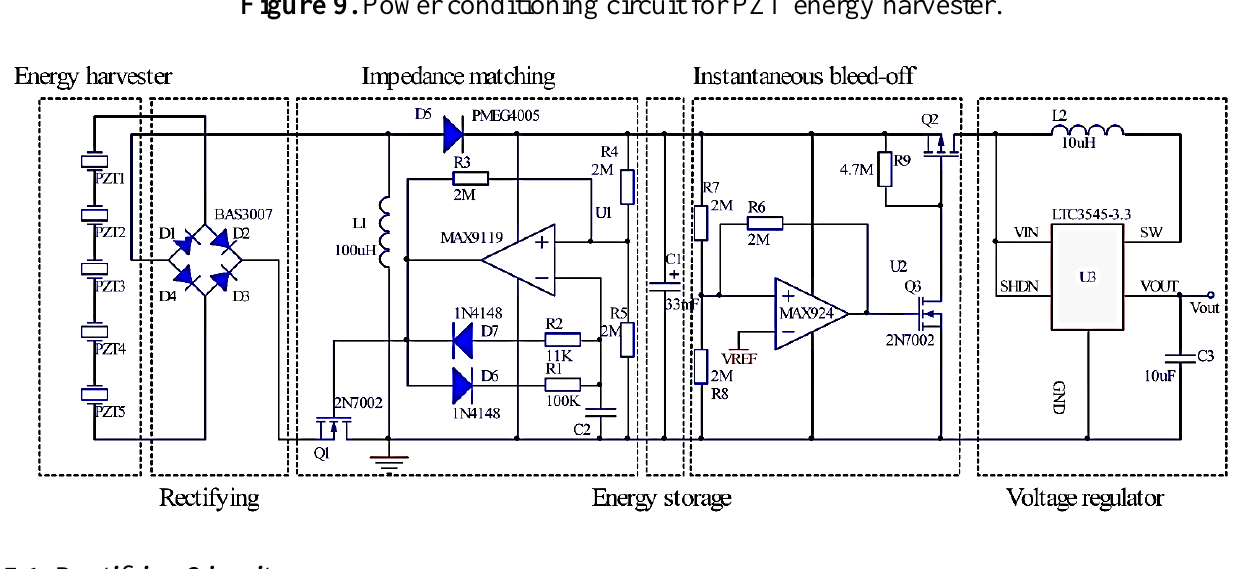
Figure 9. Power conditioning circuit for PZT energy